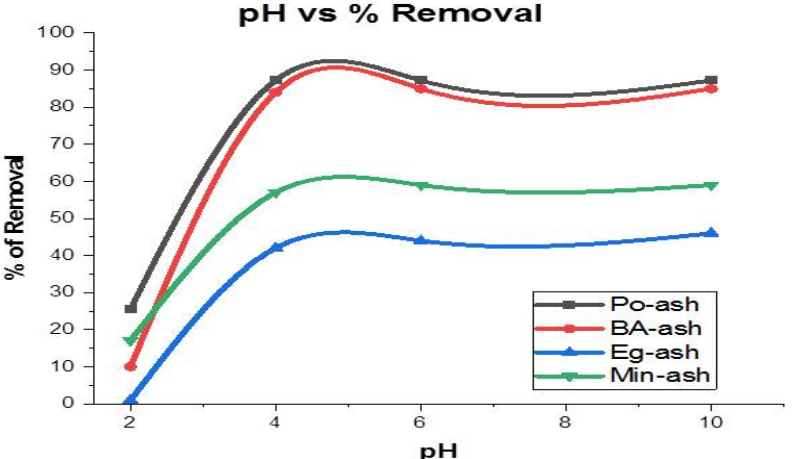
Figure 8. The influence of pH on the Removal of Ca ions.